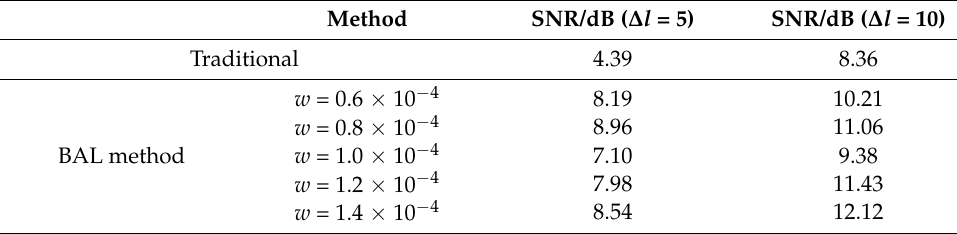
Table 1. Numerical comparison of the reconstruction SNR of different decoding